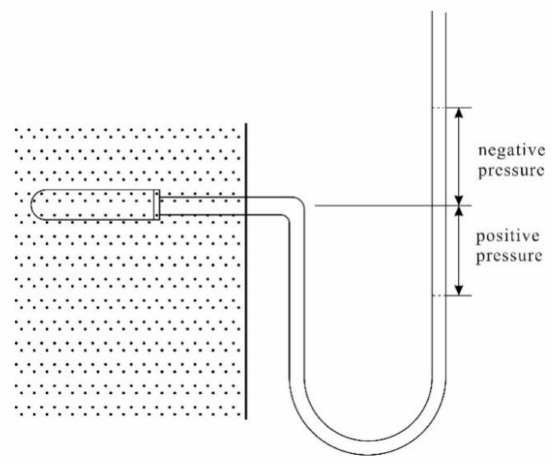
Figure 3. Schematic diagram of the